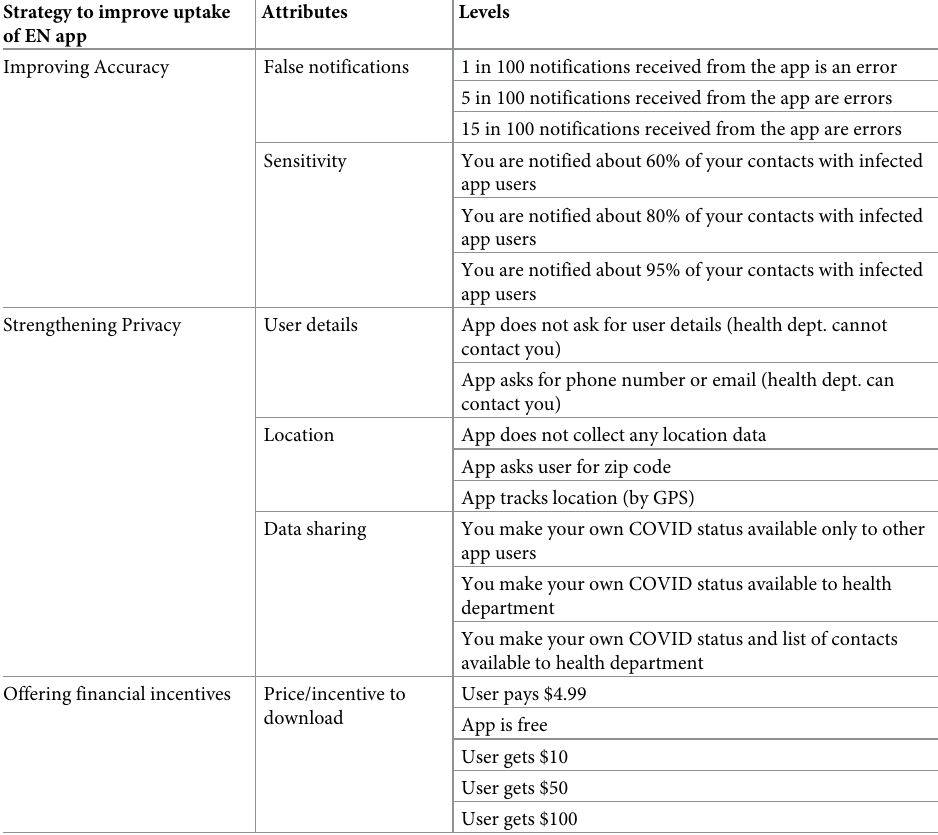
Table 1. Strategies, attributes and levels included in the discrete choice